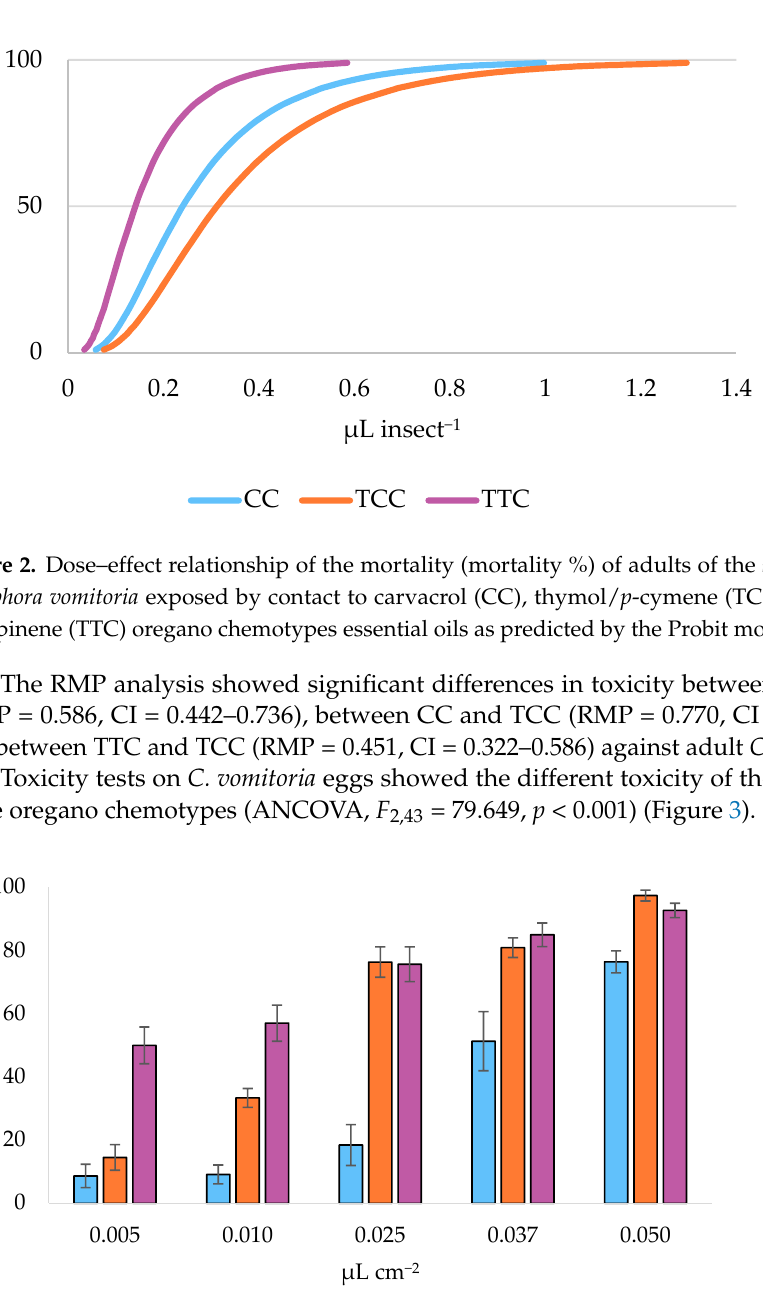
Table 4. Adjusted estimated marginal (EM) means of the mortality of Calliphora vomitoria eggs exposed to the essential oils extracted from different oregano chemotypes.